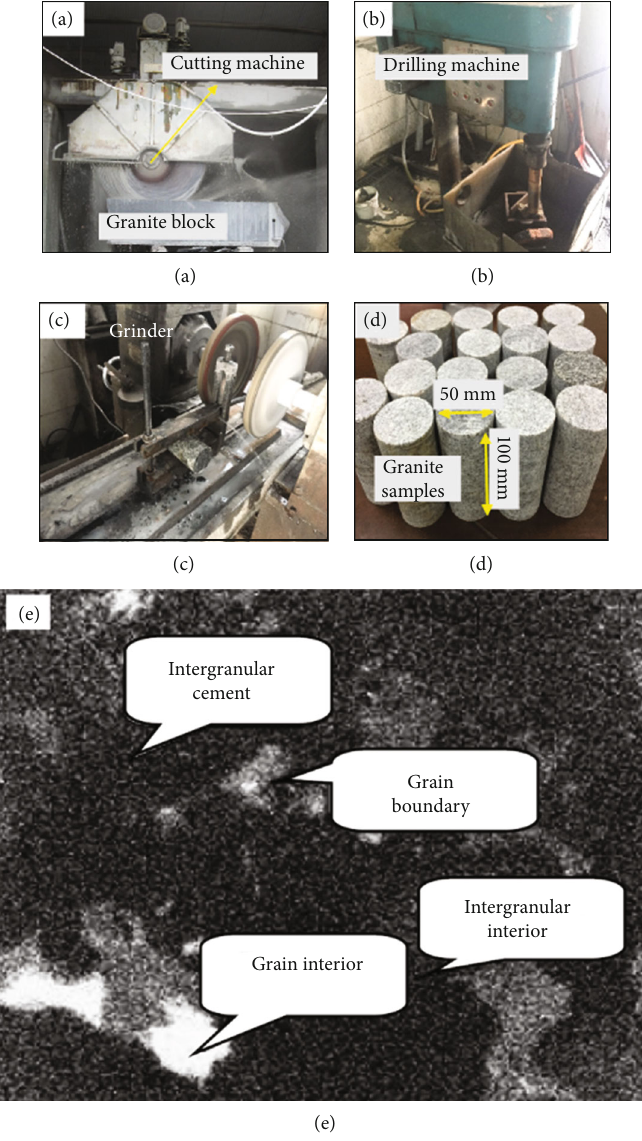
Figure 2: Photographs showing sample preparation and the meso-images of Luhui granite structure. (a) Rock saw cutting the granite block; (b) Core drill coring a smaller granite block; (c) Grinding the ends of a granite core; (d) Finished granite specimens 50mm in diameter and 100mm long; (e) Meso-image of Luhui granite structure at room temperature [7,